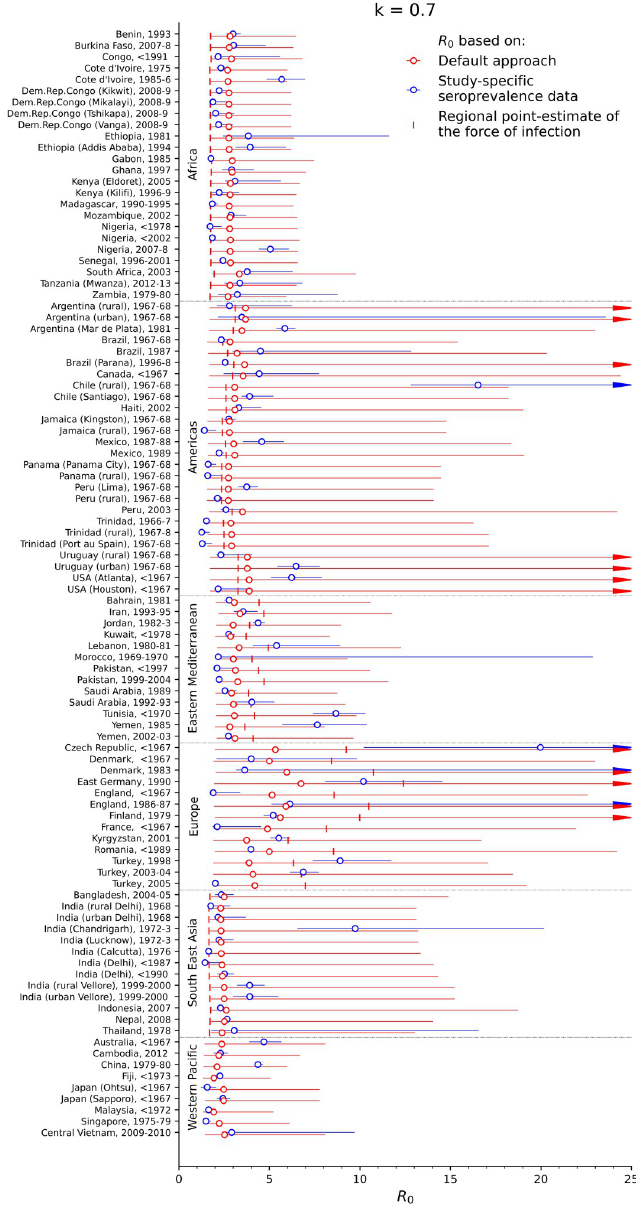
Fig 1. Estimates of the basic reproduction number for each of the studies. The blue circles reflect the values calculated from study-specific seroprevalence data (study-specific point estimates), the red circles reflect the default R 0 estimates and the vertical markers reflect R estimated from the regional point estimate of the force of infection. The 0 red and blue bars reflect the 95% ranges of the study-specific and default estimates based on bootstrapping.